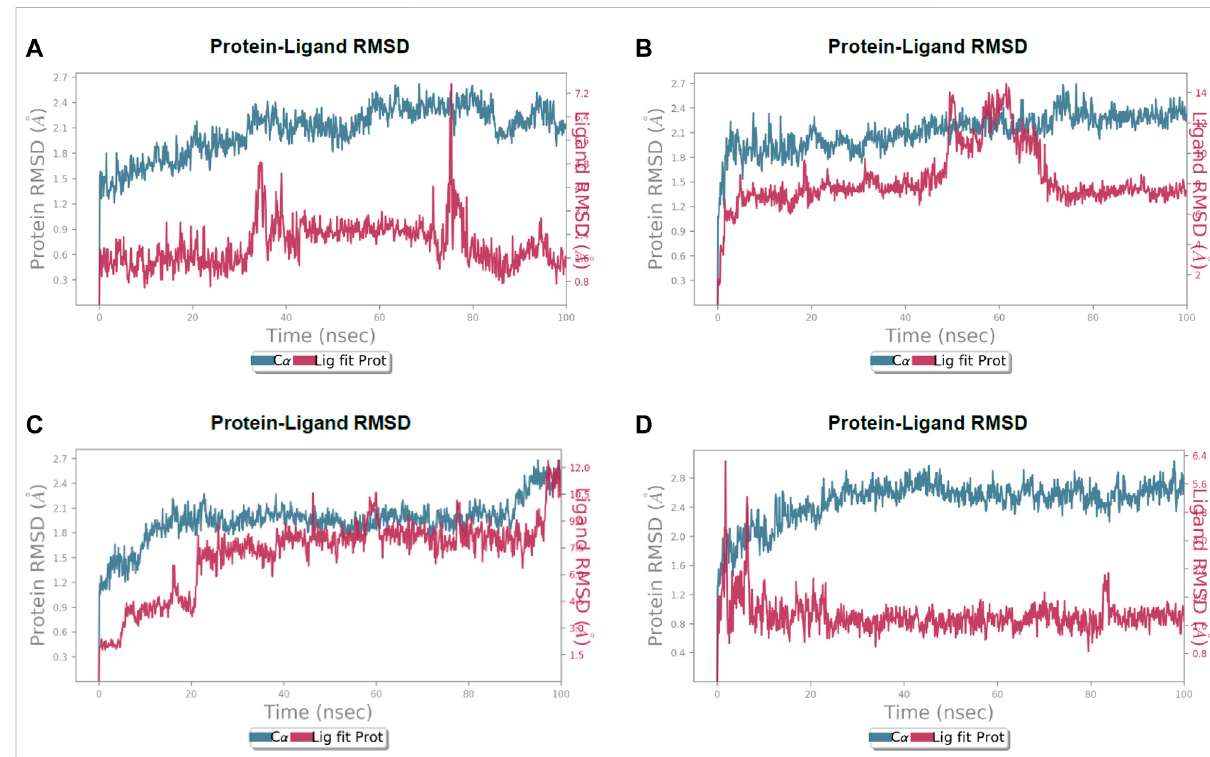
FIGURE 5 CalculatedRMSDvaluesforalphacarbon(C α )atoms(bluecurve)of3CLproteaseandprotein fi tligands viz ., (A) lochocarpolA, (B) broussonolE, (C) diplacol, (D) dexamethasone, were plotted with respect to 100 ns simulation